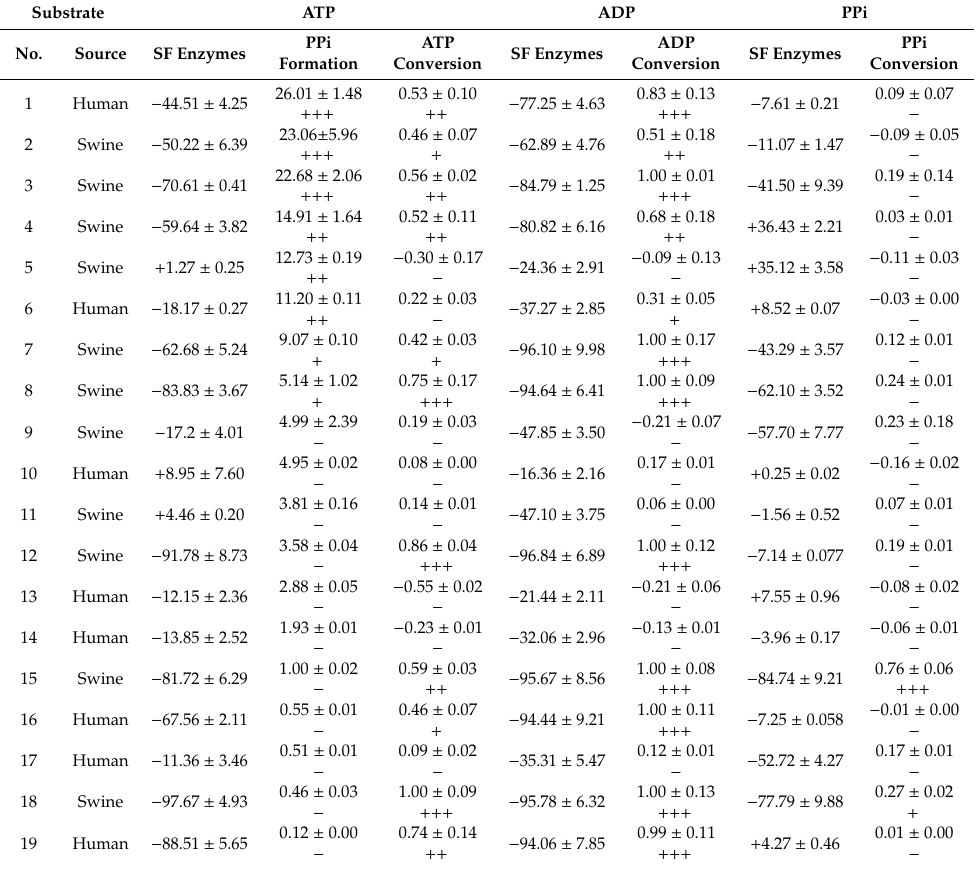
Table 3. ATP-related enzymatic reactions in synovial fluids. The values listed were calculated using the equations summarized in Table 2. The data are arranged from highest to lowest PPi